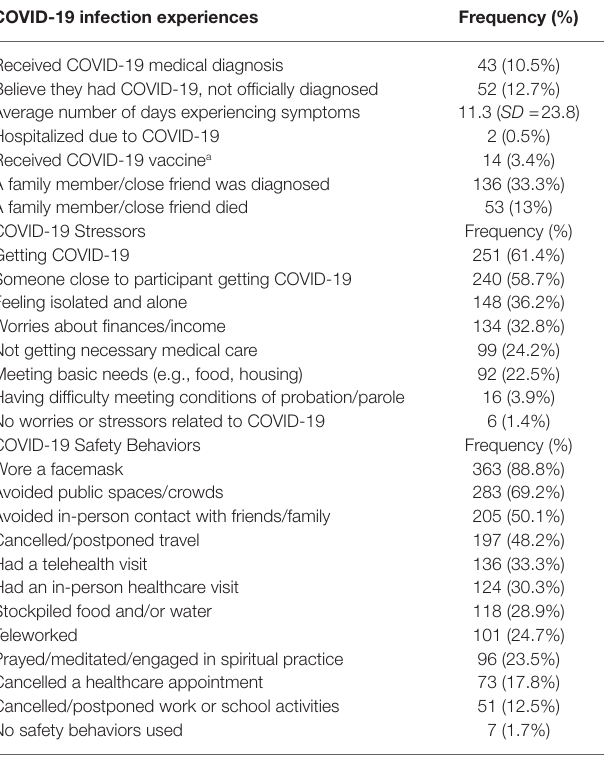
TABLE 4 | Veteran experiences with COVID-19 health, stressors, and safety